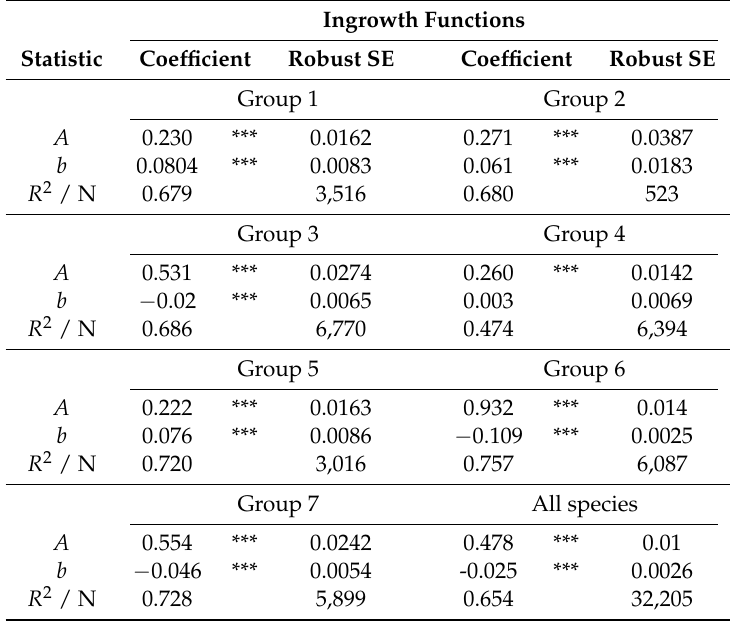
Table 6. Parameters of the ingrowth probability functions by group of species ( 1 )